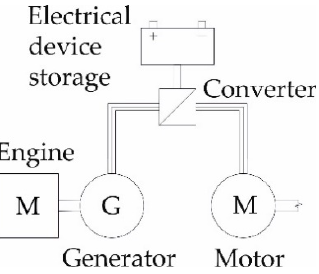
Figure 2. Electro-hybrid configuration.